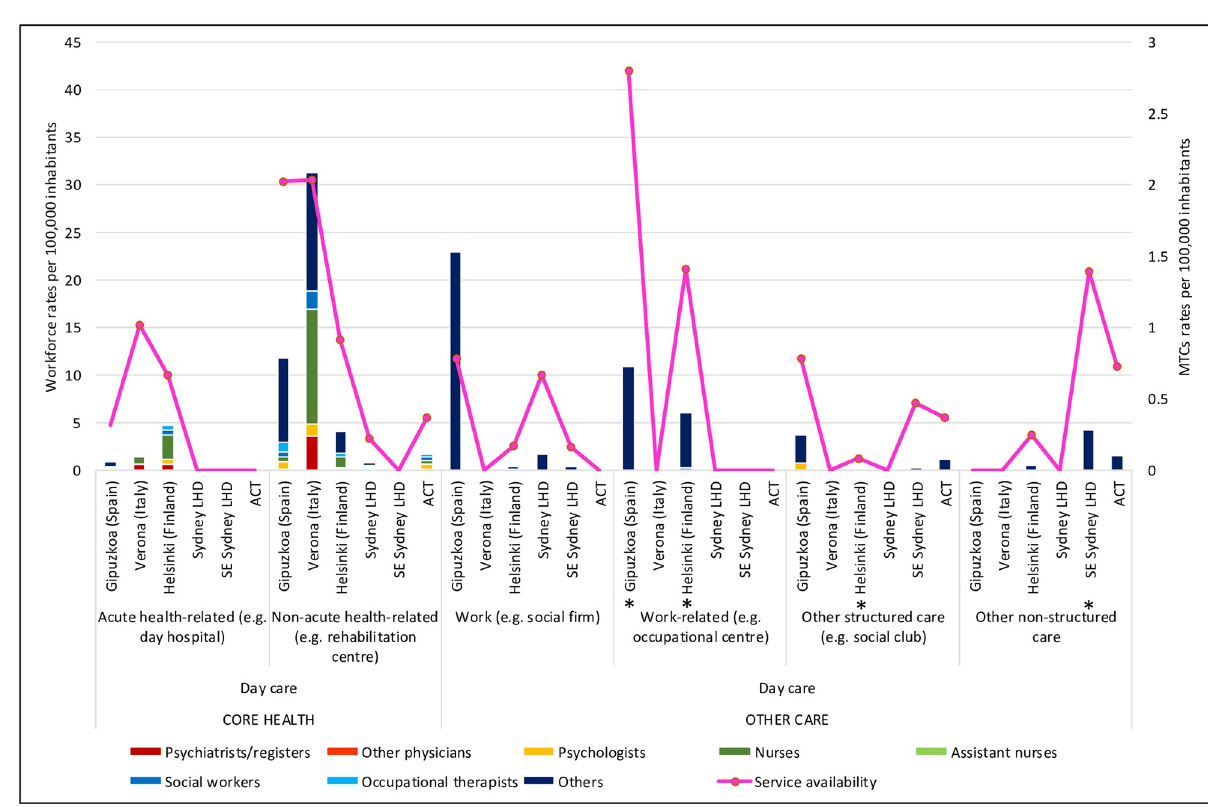
Fig 3. Workforce rates and availability in adult mental health services for day care in the six study areas. � Missing data.